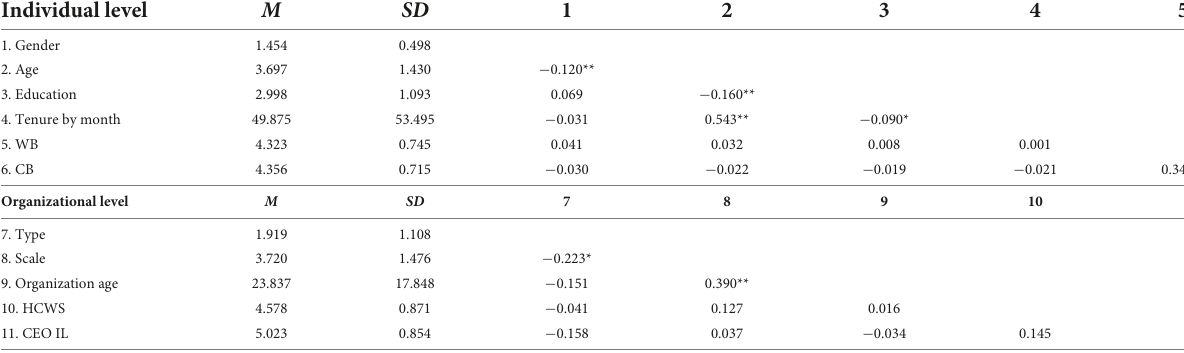
TABLE 3 Means, standard deviation and variables correlation.